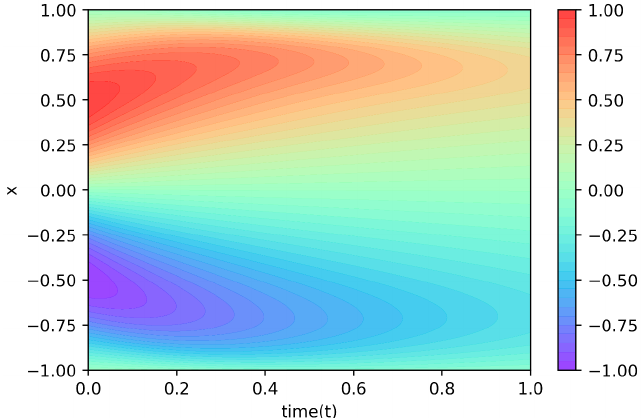
Figure 5. Solution of the Korteweg-de Vries (KdV)–Burgers equation given by physics-informed neural networks.